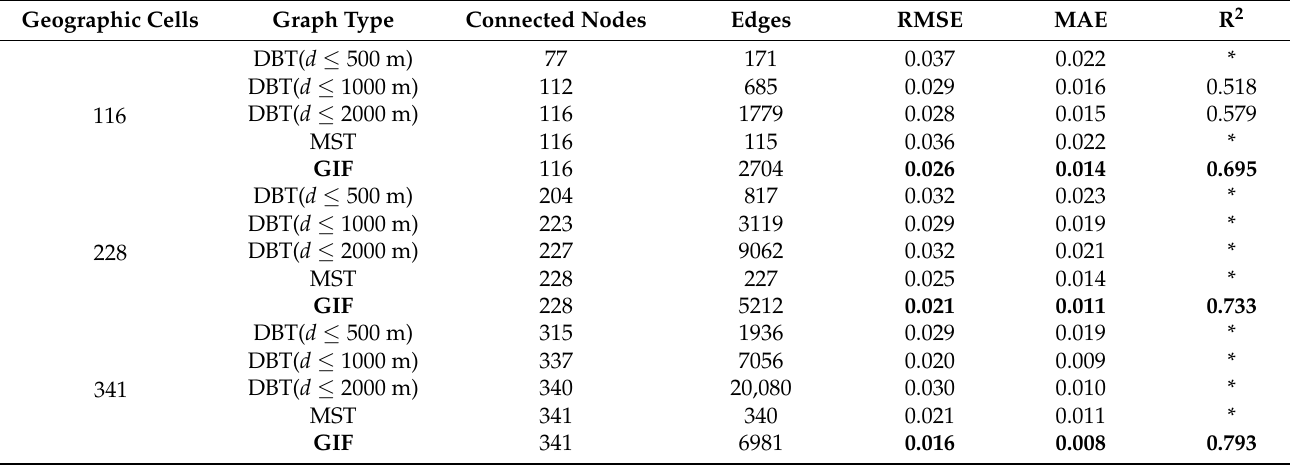
Table 2. Predictive accuracy of the graph construction methods at different scales, as indicated by distance ( “d ”). Geographic Cells Graph Type Connected